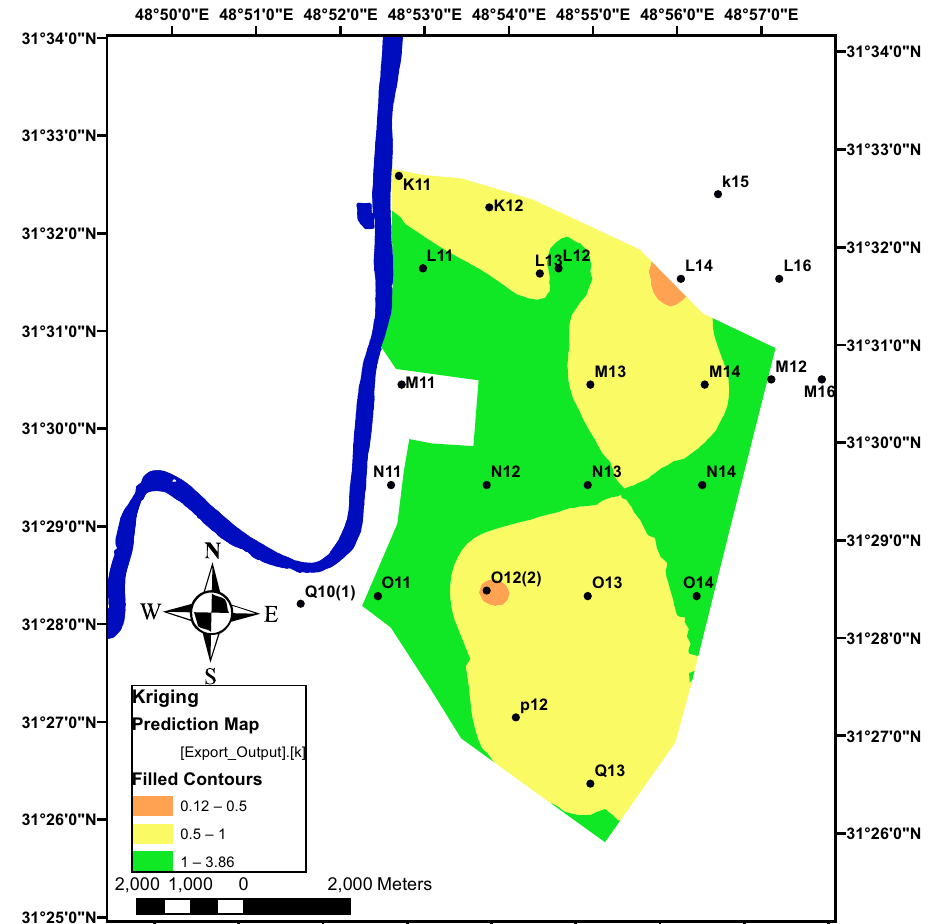
Fig. 7 Estimate of hydraulic conductivity in the area by simple Kriging